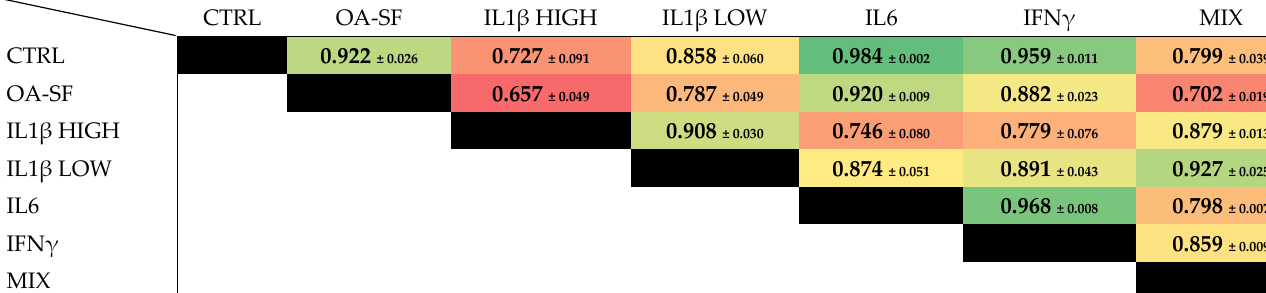
Table 1. Correlation analysis for gene expression profiles of control and treated chondrocytes.